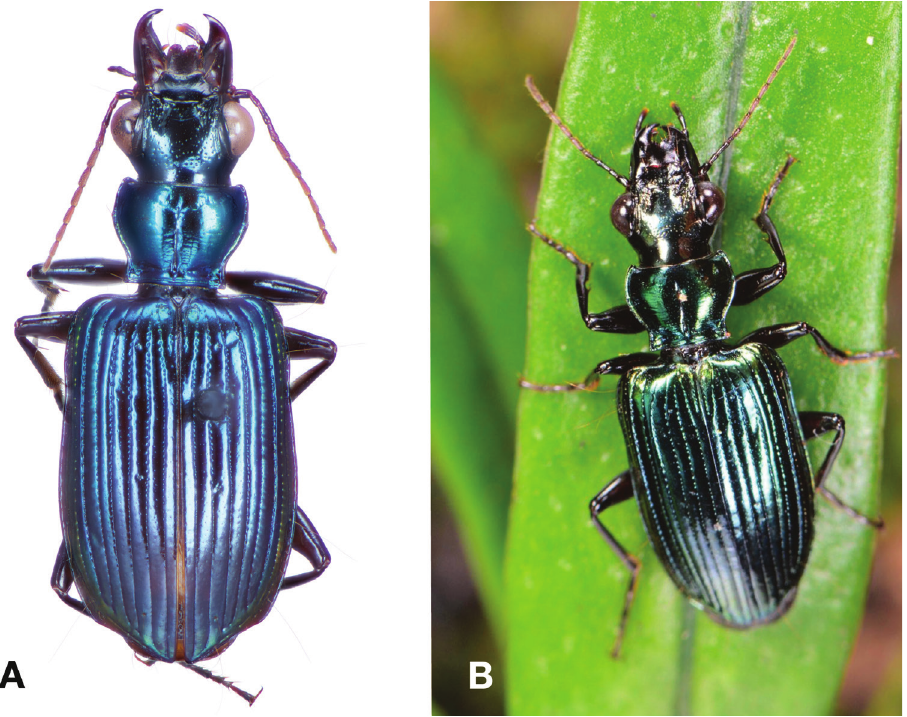
Figure 24. Dorsal habitus and color pattern of Catascopus ( s. str. ) ignicinctus Bates. A common purple metallic morph (OBL 10.85 mm) B live image of green color morph.